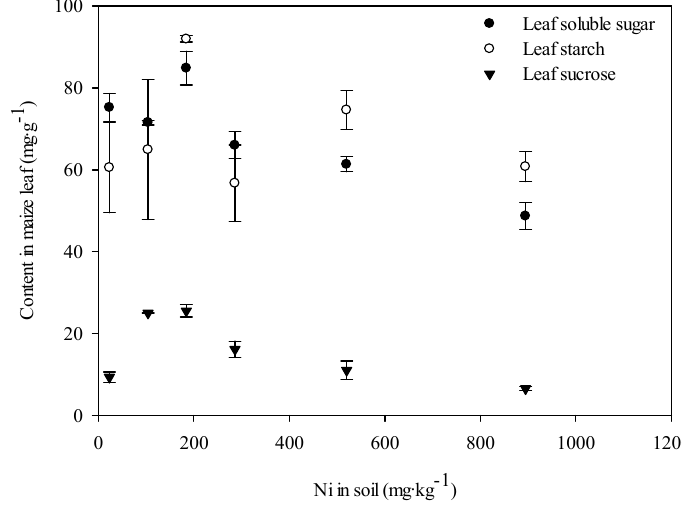
Figure 5. Effects of Ni (added as NiCl 2 ) on the leaf soluble sugar, sucrose, and starch contents of maize.